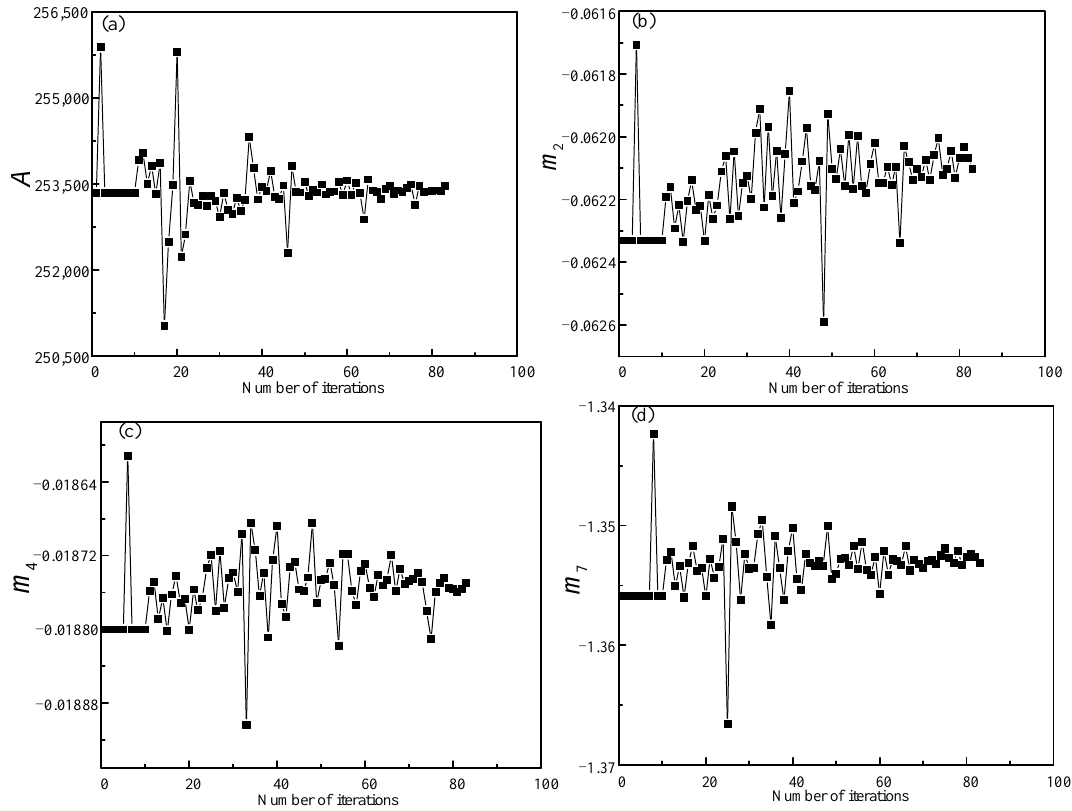
m ; ( c ) m ; ( d ) m . Figure 10. Optimization curves of parameters: ( a ) A ; ( b ) m 2 ; ( c ) m 4 ; ( d ) m 7 2 4 7